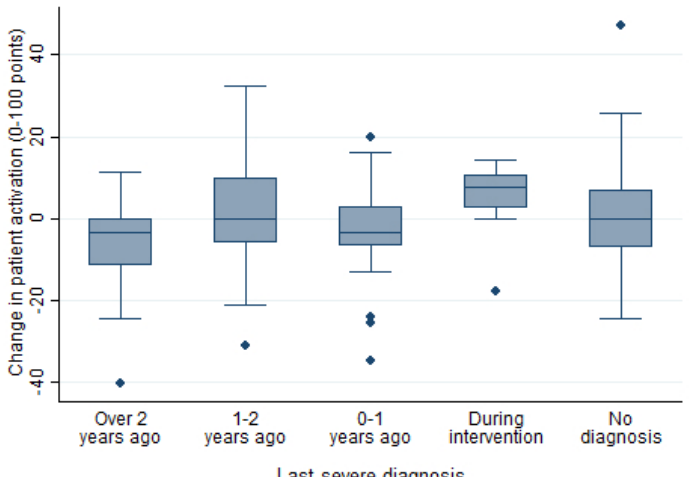
Figure 5. Changes in patient activation scores by time since last severe diagnosis (n=137).